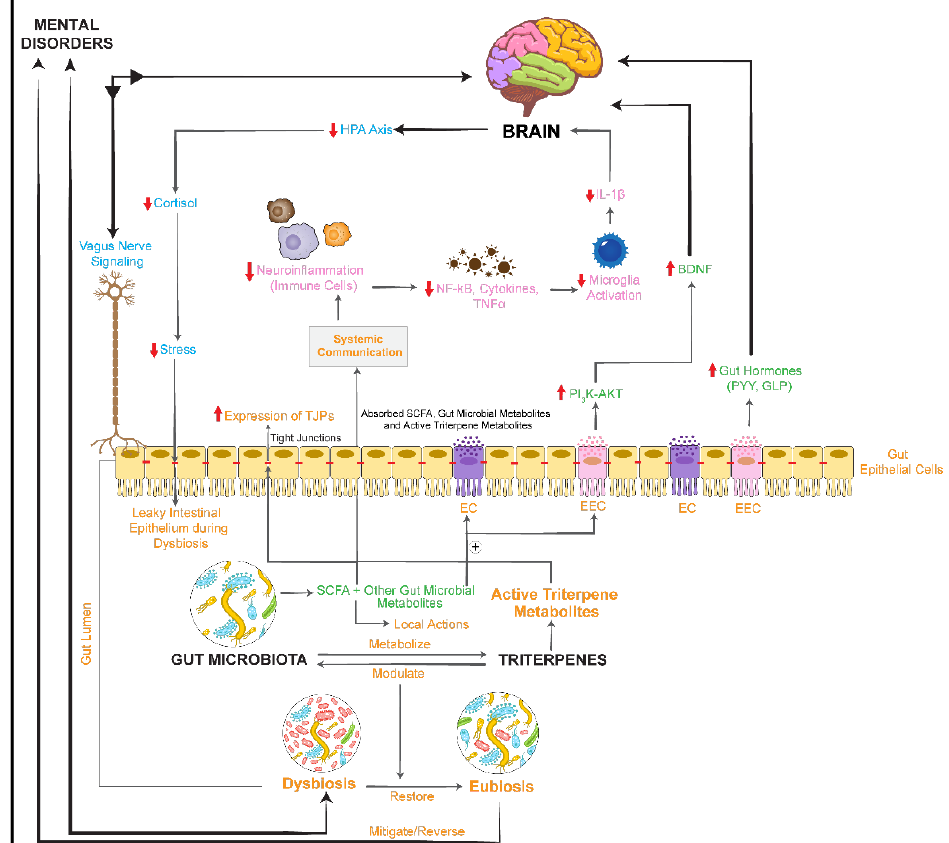
Figure 3. Potential gut–brain communication pathways modulated by triterpenes in mental disorders. Triterpenes (such as ginsenosides) can alter gut–brain microbiome communication in impaired brain function and promote a healthy mental state. These beneficial effects are related to rebalancing the gut microbiome and influencing neural (blue letters), immune (pink letters), and humoral/metabolic (green letters) pathways. Triterpene glycosides are metabolized by the gut microbiome into active components (e.g., ginsenosides into compound K). These active metabolites are more bioavailable than the native compounds. Ginsenosides and their metabolites promote neurotrophic factors and reduce pro-inflammatory mediators and stress levels [207,209–211]. The major gut–brain mechanisms by which ginsenosides have a beneficial effect are marked with red arrows ( activation/upregulation, inhibition/downregulation). TJPs: tight junction proteins; BDNF: brain-derived neurotrophic factor; PI3K: phosphoinositol 3 phosphate; AKT: protein kinase B; IL- 1β: interleukin- 1β; NF - κB: nuclear factor - κB; PYY: peptide YY; GLP1: glucagon -like peptide 1; : stimulates/promotes.